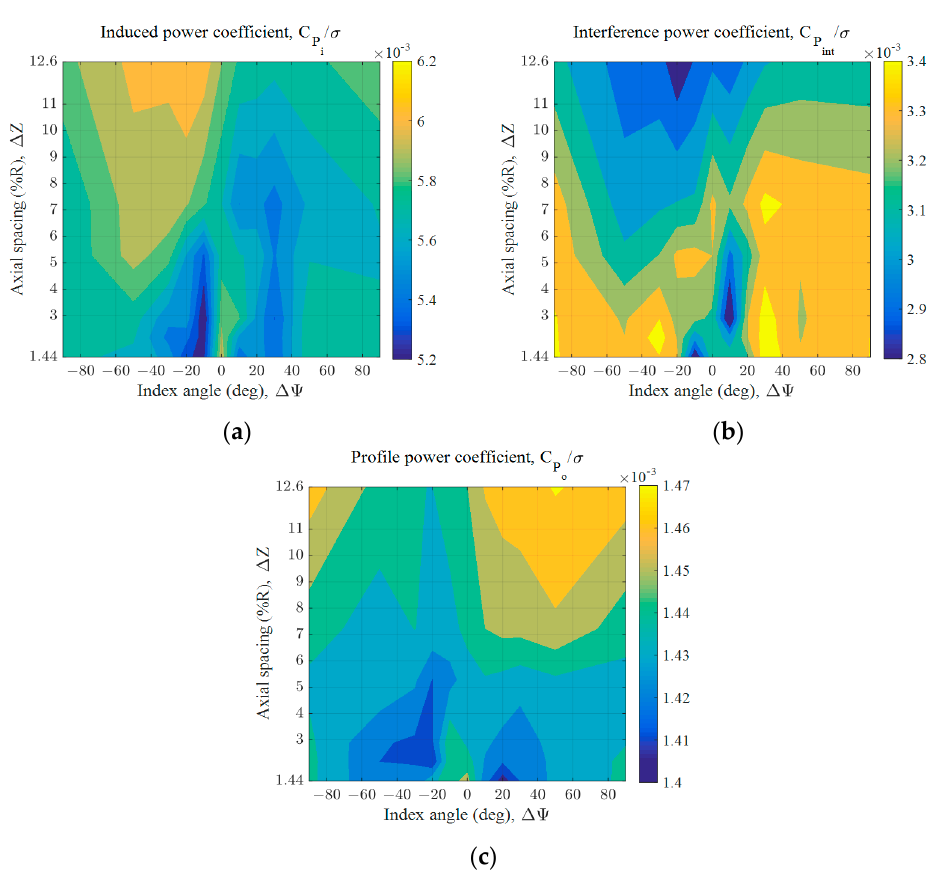
Figure 11. Rotor power components with different index angles and axial spacings (collective pitch angle = 12°): ( a ) Induced power ( C